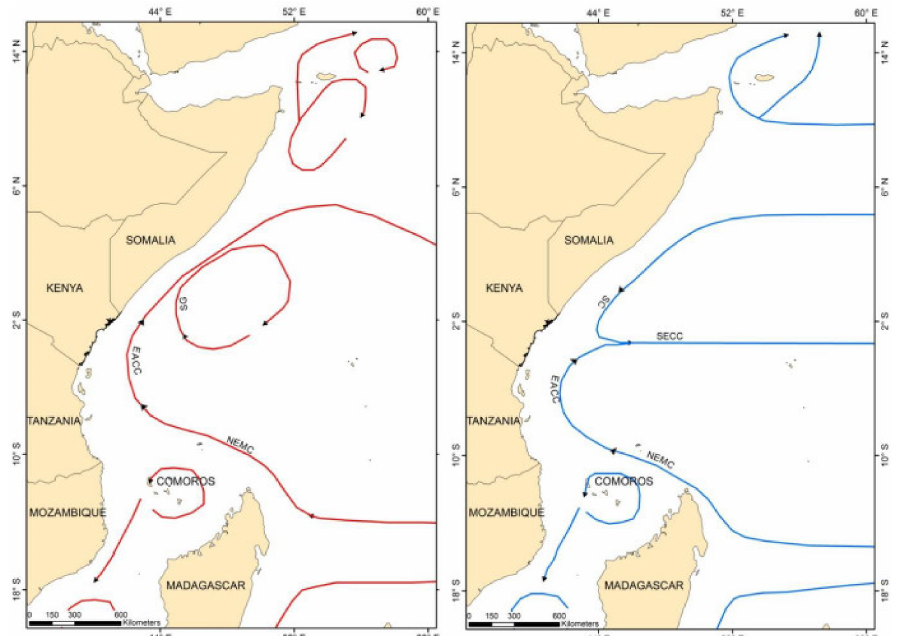
Figure 2. Oceanographic currents off the Kenyan coast. The southeast monsoon is shown in red on the right and the northeast monsoon in blue. SC is the Somali Current, EACC is the East African Coastal Current, and SECC is the South Equatorial Counter Current. Source: Tychsen & Klinge